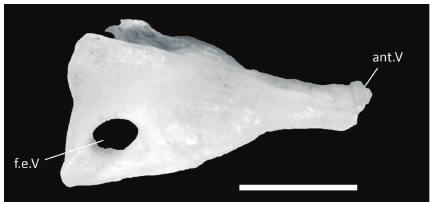
Figure 8: Medial view of the vomer of Sordellina punctata (IBSP 41071). Bar = 1 mm. Abbreviations other than in previous figures: ant.V: anterior process of vomer; f.e.V: exochoanal fenestra of